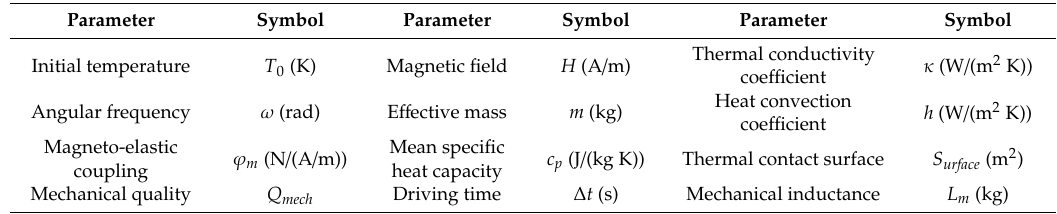
Table 1. Parameter look-up